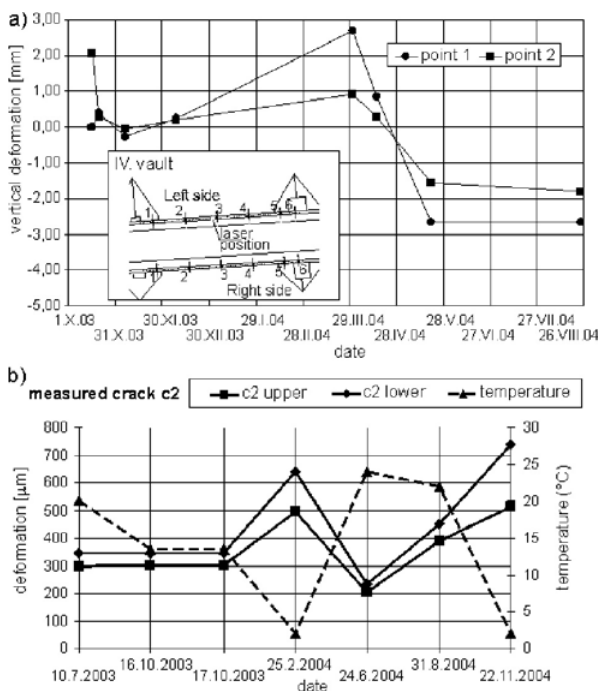
Fig 16. Transverse horizontal deformations of breast wall